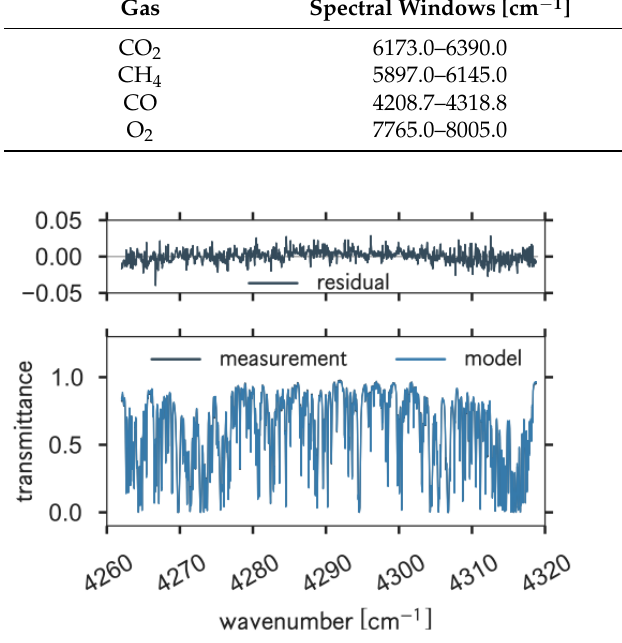
Figure 2. Typical measured atmospheric spectrum, mode spectrum, and residuals. Table 1. Spectral windows for retrieval of the column of CO 2 , CH 4, and CO.